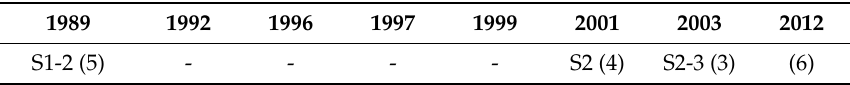
Table 2. Crest: Time periods and control stations with uplift movements. The numbers in brackets show the max uplift movement in mm that has taken place between the measurement epoch on the year shown in the table and the previous year. If uplift is observed for only specific stations along the crest, these are also